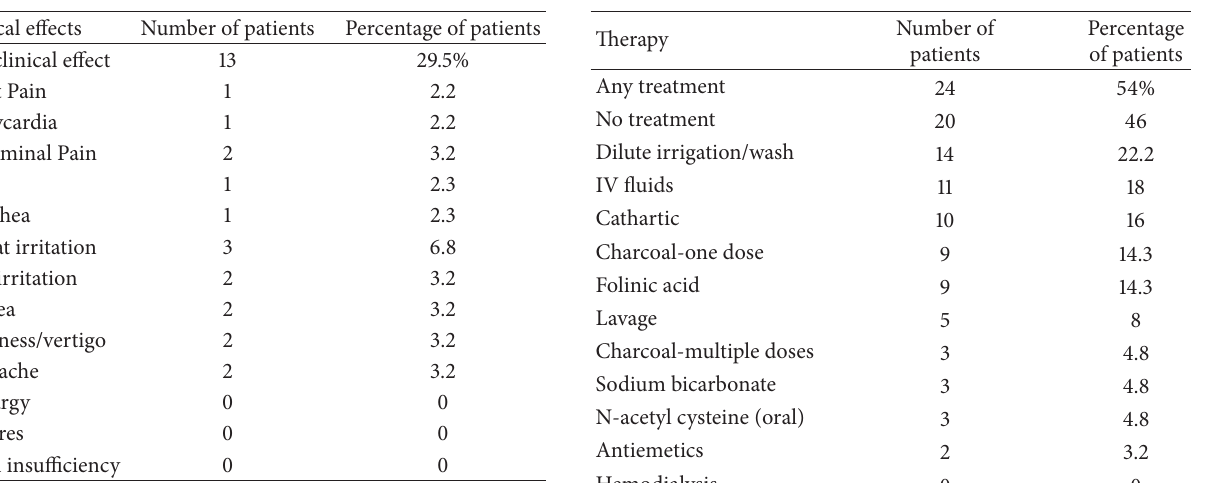
Table 1: Clinical effects of acute methotrexate ingestions in adults as reported to six poison centers ( 𝑁 = 44 ).